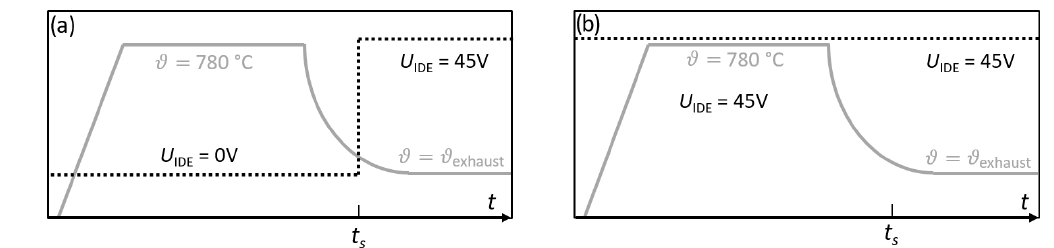
Figure 3. Schematic comparison of (a) the regular operating strategy and (b) the alternative strategy, called prepolarization, at high temper- atures. In the case of (b) , the measurement voltage is switched on during the whole regeneration phase.